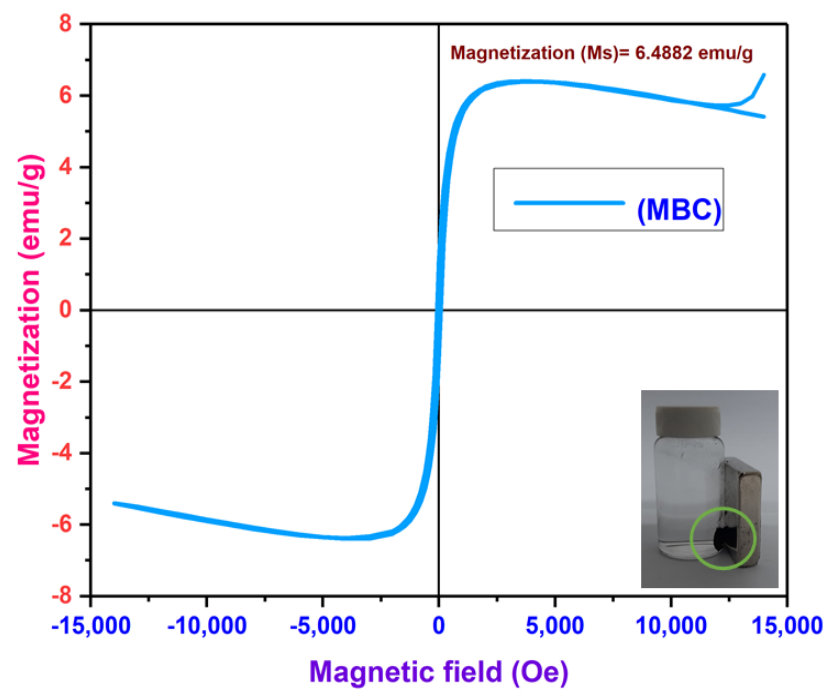
Figure 4. Magnetization curve for